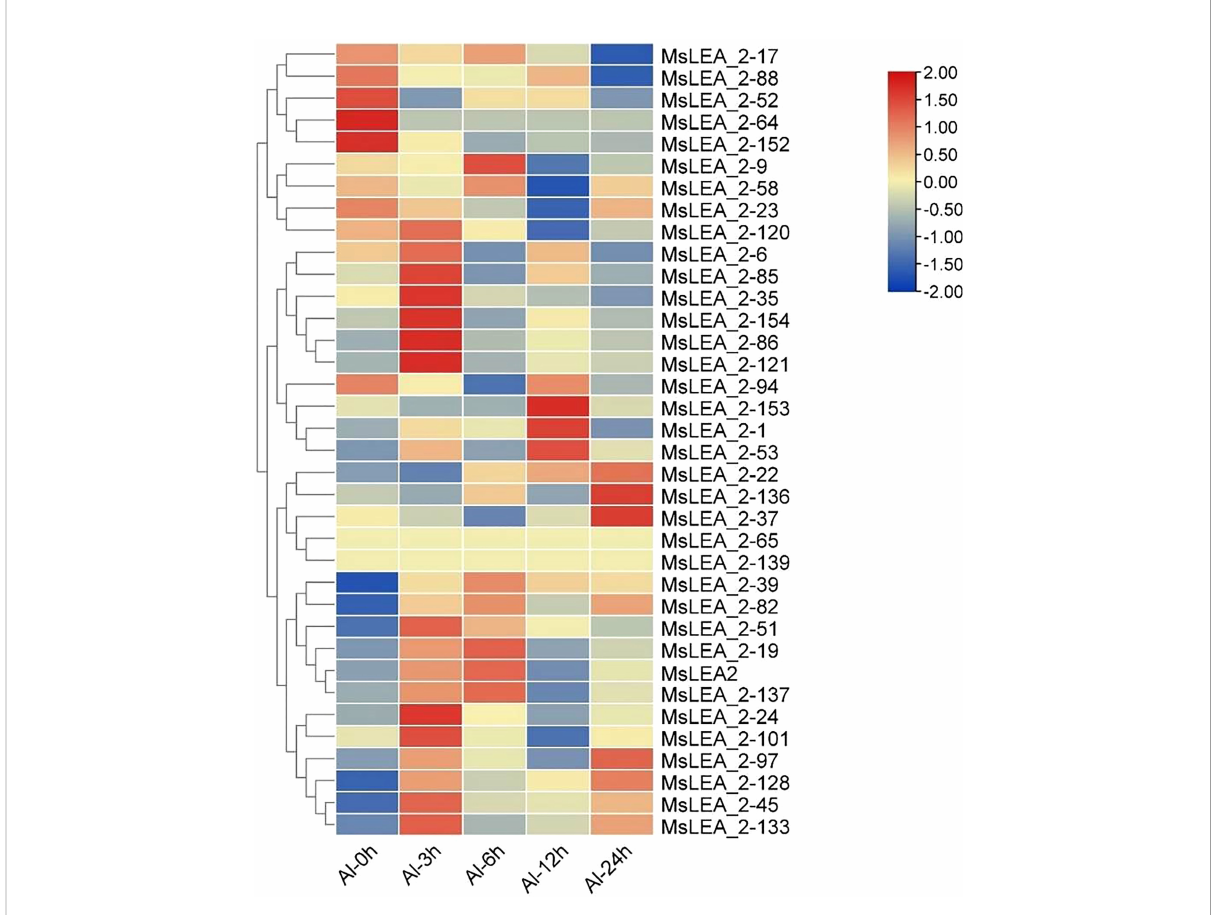
FIGURE 9 RNA-seq expression pro fi les of parts of MsLEA_2 genes under Al treatment. The heatmap was constructed using TBtools. The color scale on the right represents relative expression levels: Red represents high level and blue represents low